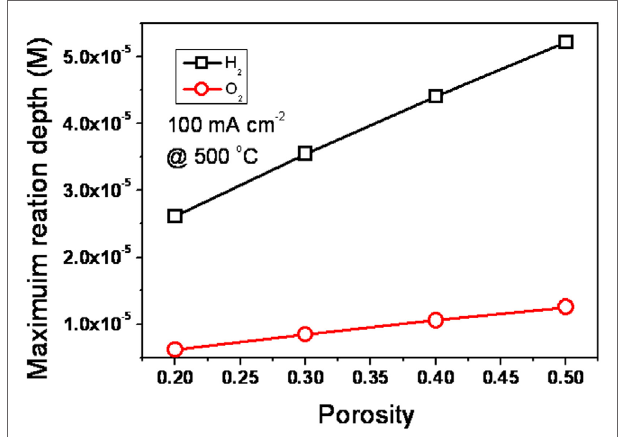
FiGURe 4 | The effect of porosity on the reaction depth in the eFFC device . [Permission from Liu et al. (2012). Available from: http://pubs.rsc.